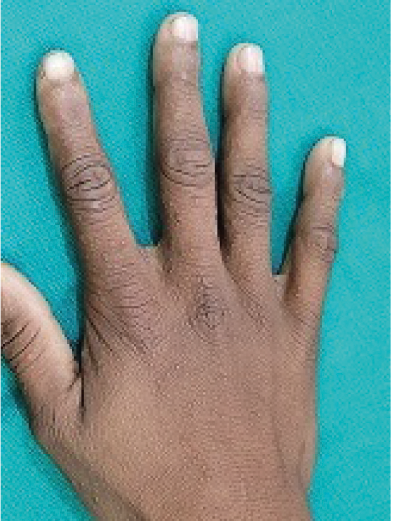
Figure 2: Multiple keratotic papules over the dorsum of bilateral feet.